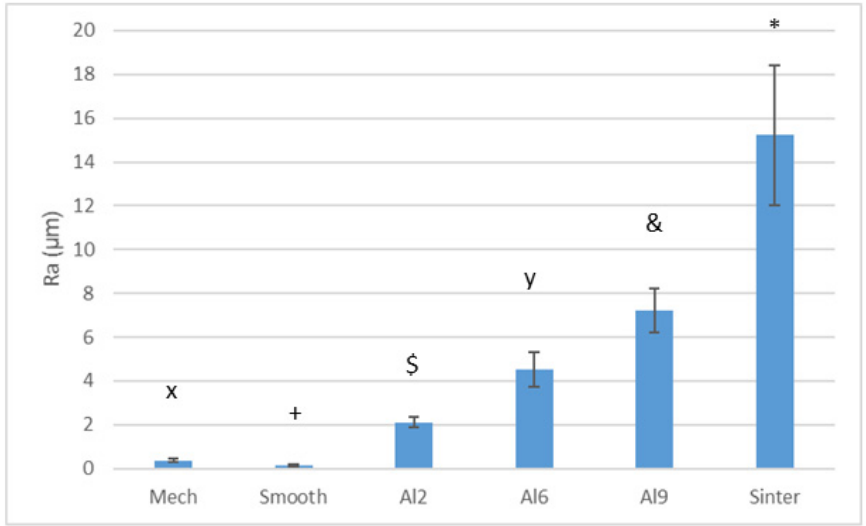
Figure 3. Roughness (Ra) obtained by each treatment. Each symbol means that the results were different with statistical significance to the other symbols. All the results present difference with statistical significance at p < 0.01. For the Ra values, the different surface treatments showed roughness values that were all statistically different from each other.